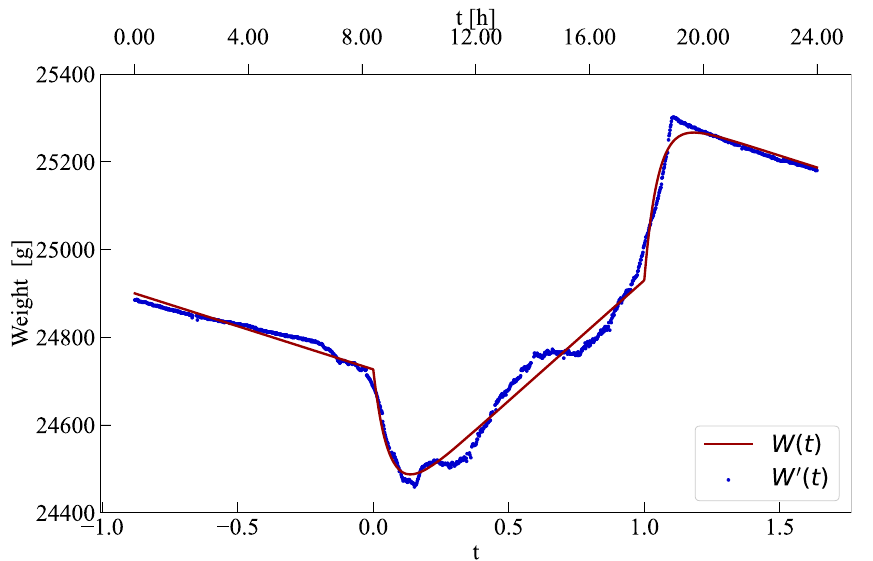
Fig 4. Comparison between the model and data. Data corresponds to measurements on 2018–4-7 for ‘Hive 6’. By fixing τ = 49 min, the estimated parameters are N = 5830 bees, W 0 = 24068 g, m = 0.03 g/bee, a 1 = 0.99 h − 1 , a 2 = 2.1 d max h − 1 , d = 0.85 h − 1 , l = 20.66 g/h, t 0 = 8.40 h and t 1 = 17.93 h.